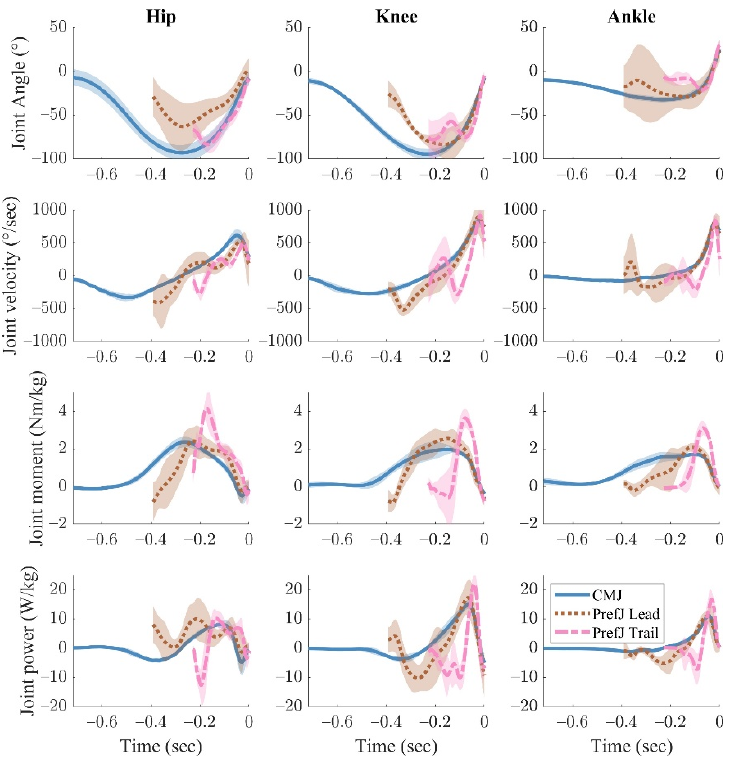
Figure 3. Ensemble average of the hip ( left column ), knee ( middle column ), and ankle ( right column ) joint angles ( first row ), joint angular velocities ( second row ), net joint moments ( third row ), and net joint powers ( fourth row ) during the countermovement jump (CMJ) and preferred-style jump (PrefJ).